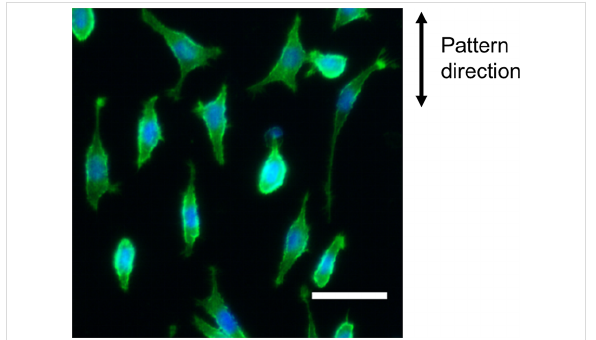
Figure 4: Fluorescence micrograph of the L929 cells cultured on the topography substrate (developed SU-8 surface). Scale bar: 20 μ m.